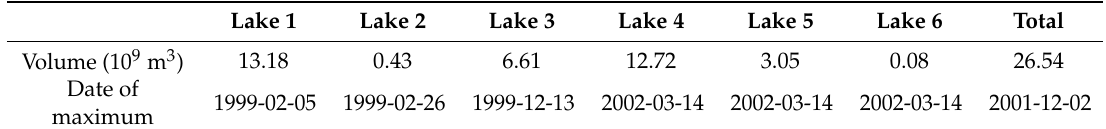
Table 7. Maximum volumes and dates of maximum for each